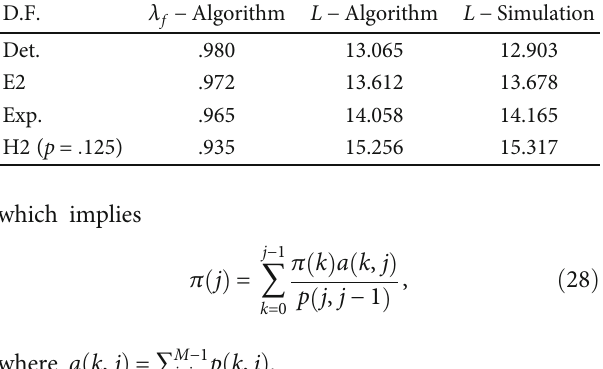
Table 4: The model with M = 60 , N = 40 , Y = 20 , and ρ = 0 : 025 . D.F.